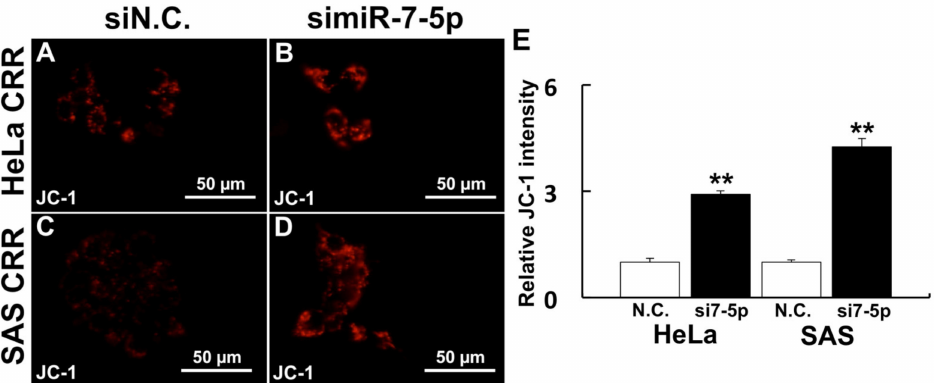
Figure 2. Knockdown of miR-7-5p enhanced ∆Ψ m. ∆Ψ m was visualized by 2 µ M JC-1 after the miR-7-5p knockdown. JC-1 is a fluorescent probe that is localized mitochondria and is changed fluorescence according to the membrane potential. ( A ) HeLa CRR cells siN.C. treatment. ( B ) HeLa CRR cell simiR-7-5p treatment. ( C ) SAS CRR cells siN.C. treatment. ( D ) SAS CRR cell simiR-7-5p treatment. ( E ) Relative JC-1 intensity (HeLa CRR N.C.: n = 11, HeLa CRR simiR-7-5p: n = 10, SAS CRR N.C.: n = 51, SAS CRR simiR-7-5p: n = 25). **: p < 0.01 using Student’s t test. Knockdown of miR-7-5p significantly increased ∆Ψ